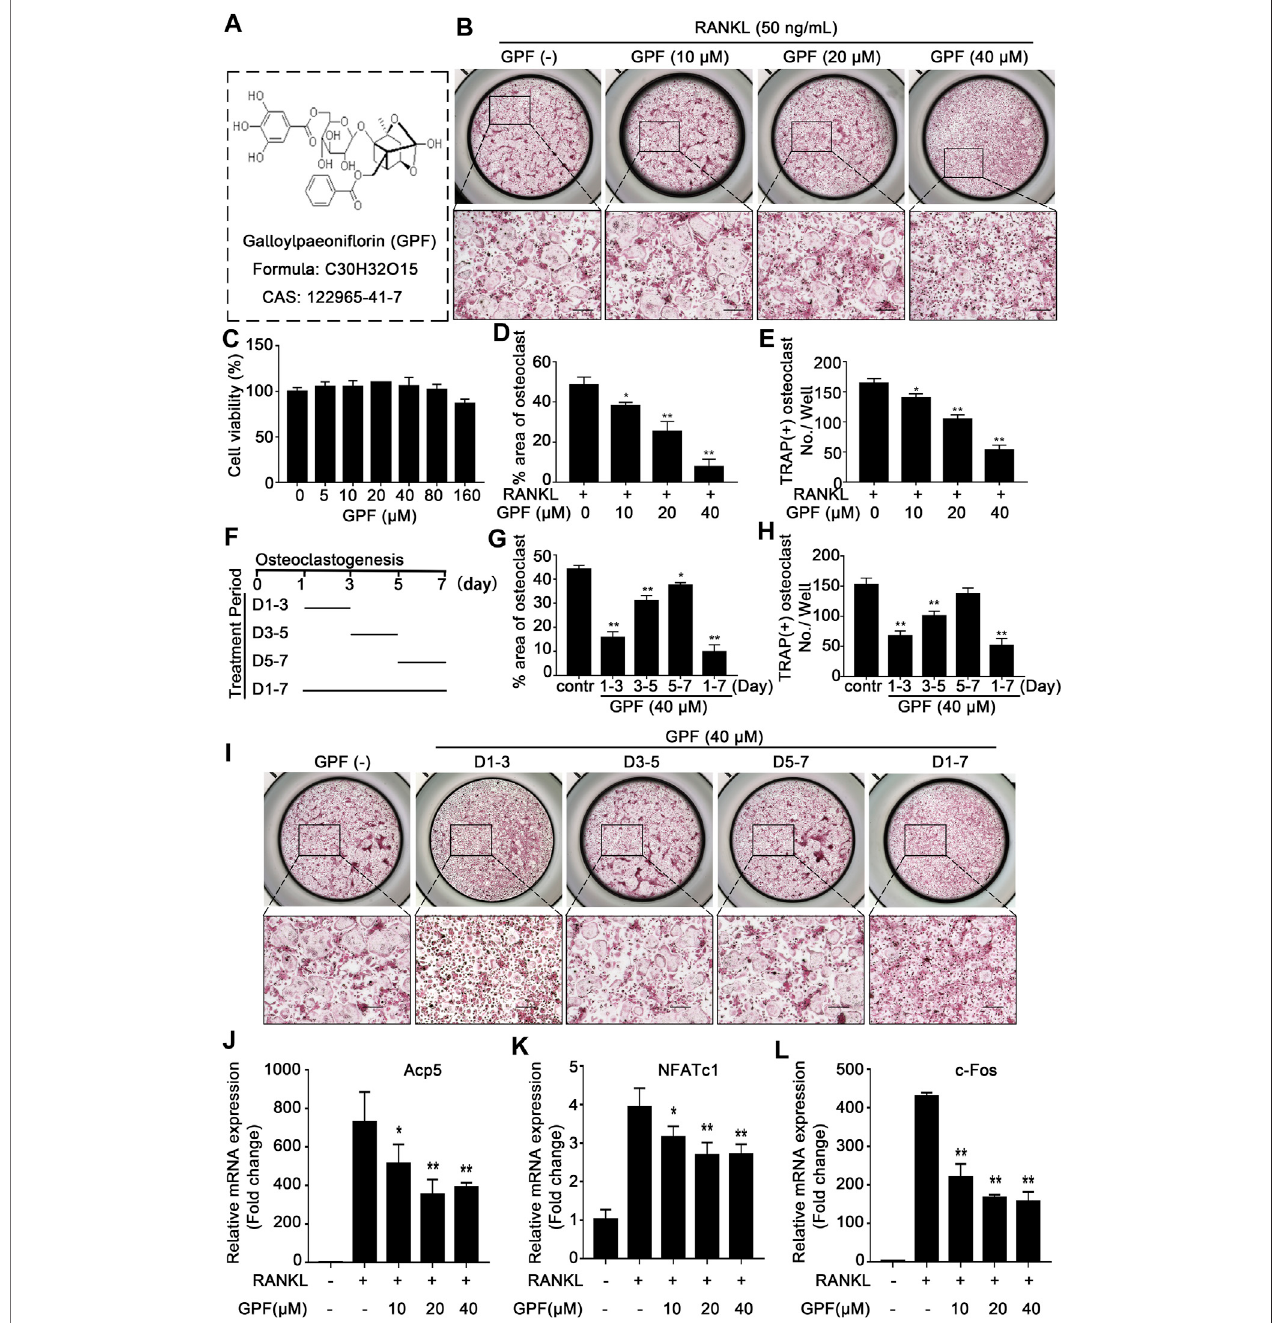
FIGURE 1 | GPF inhibits RANKL-induced osteoclastogenesis in vitro without signi fi cant cytotoxicity in the cultured cells. (A) The molecular structure and CAS number of GPF. (B) Representative images showing Inhibitory effects of GPF on osteoclastogenesis in BMMs. BMMs were incubated with RANKL and M-CSF in the absenceorpresenceofGPF(0,10,20and40 µM).Onday7,cellswere fi xedandstainedforTRAP( n (cid:2) 3). (C) CCK-8assayaftertreatingwithvaryingconcentrationsof GPFfor96 h( n (cid:2) 3). (D,E) QuantitativeanalysiswasperformedtodetectthetotalareaofTRAP-positivemultinucleatedcells(nuclei > 3)/wellandnumberofTRAP- positive multinucleated cells/well ( n (cid:2) 3). (F) The time periods of the treatment of GPF. (G,H) Quanti fi cation of TRAP-positive multinucleated cells treated with GPF in different time periods. Total area ofTRAP-positive cells/well and number of multinucleated osteoclasts were counted ( n (cid:2) 3). (I) Representative images of TRAP staining showing BMMs treated with GPF for the indicated days during osteoclastogenesis ( n (cid:2) 3). (J-L) After stimulated with RANKL for 5 days in the presence of 40 µM GPF, osteoclast-speci fi c genes expression of c - Fos , NFATc1 and Acp5 relative to GAPDH were quanti fi ed by real-time PCR and presented as fold induction. All bar graphs are presented as mean ± SD. * p < 0.05, ** p < 0.01 compared with control group (without GPF treatment). One-way ANOVA. Scale bar (cid:2) 200 µm.